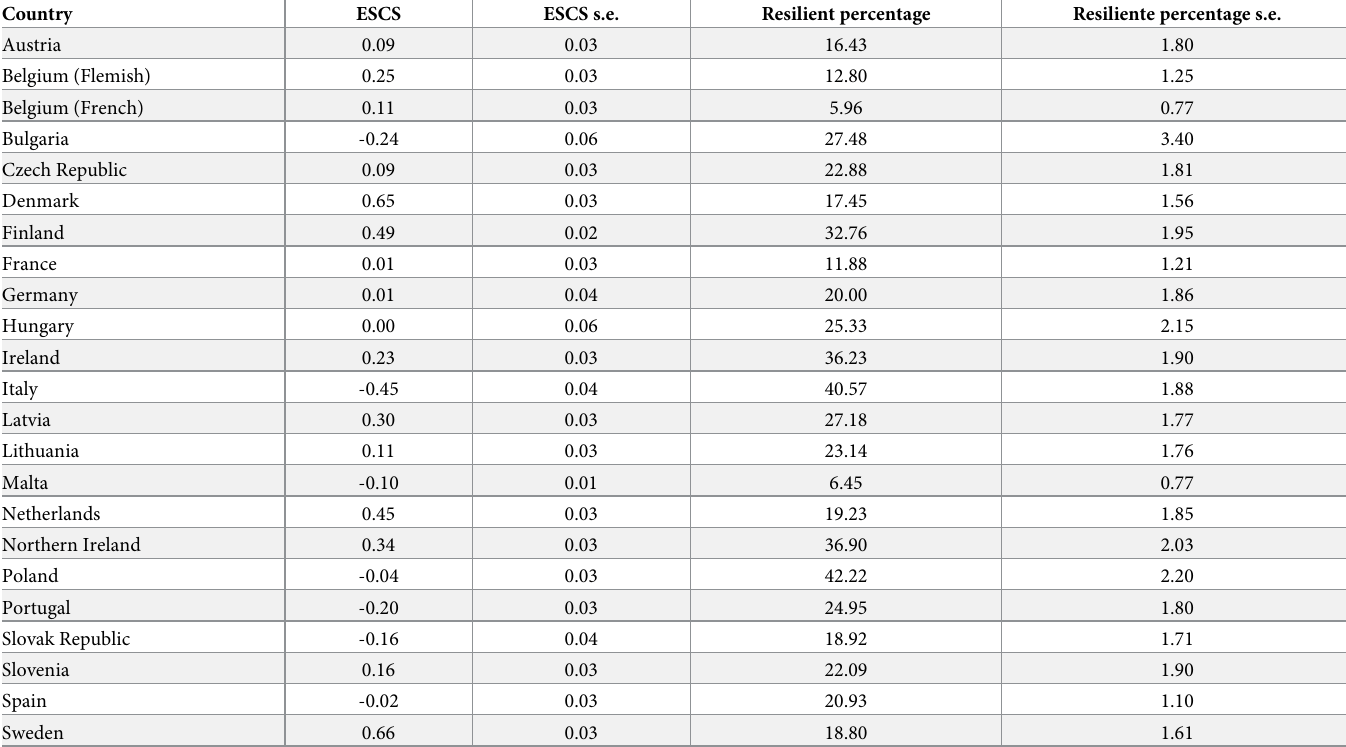
Table 2. Index of economic, social and cultural status, and percentage of resilient students for the European Union countries. Country